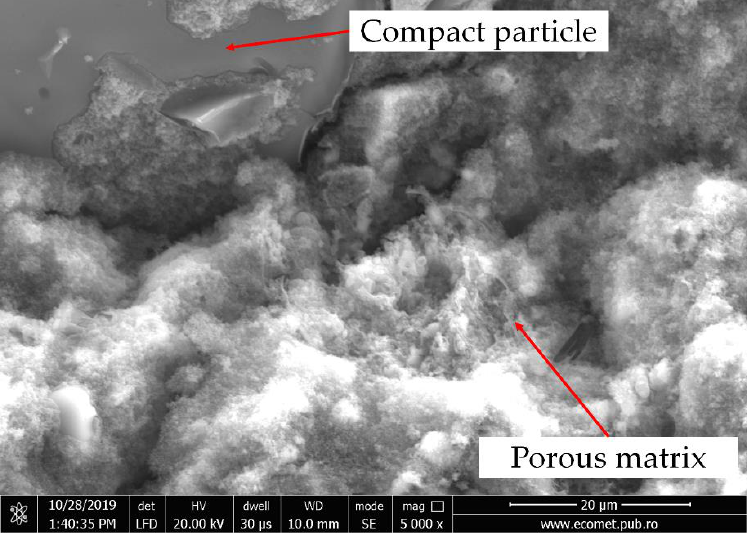
Figure 5. SEM micrographs of geopolymers with particles.